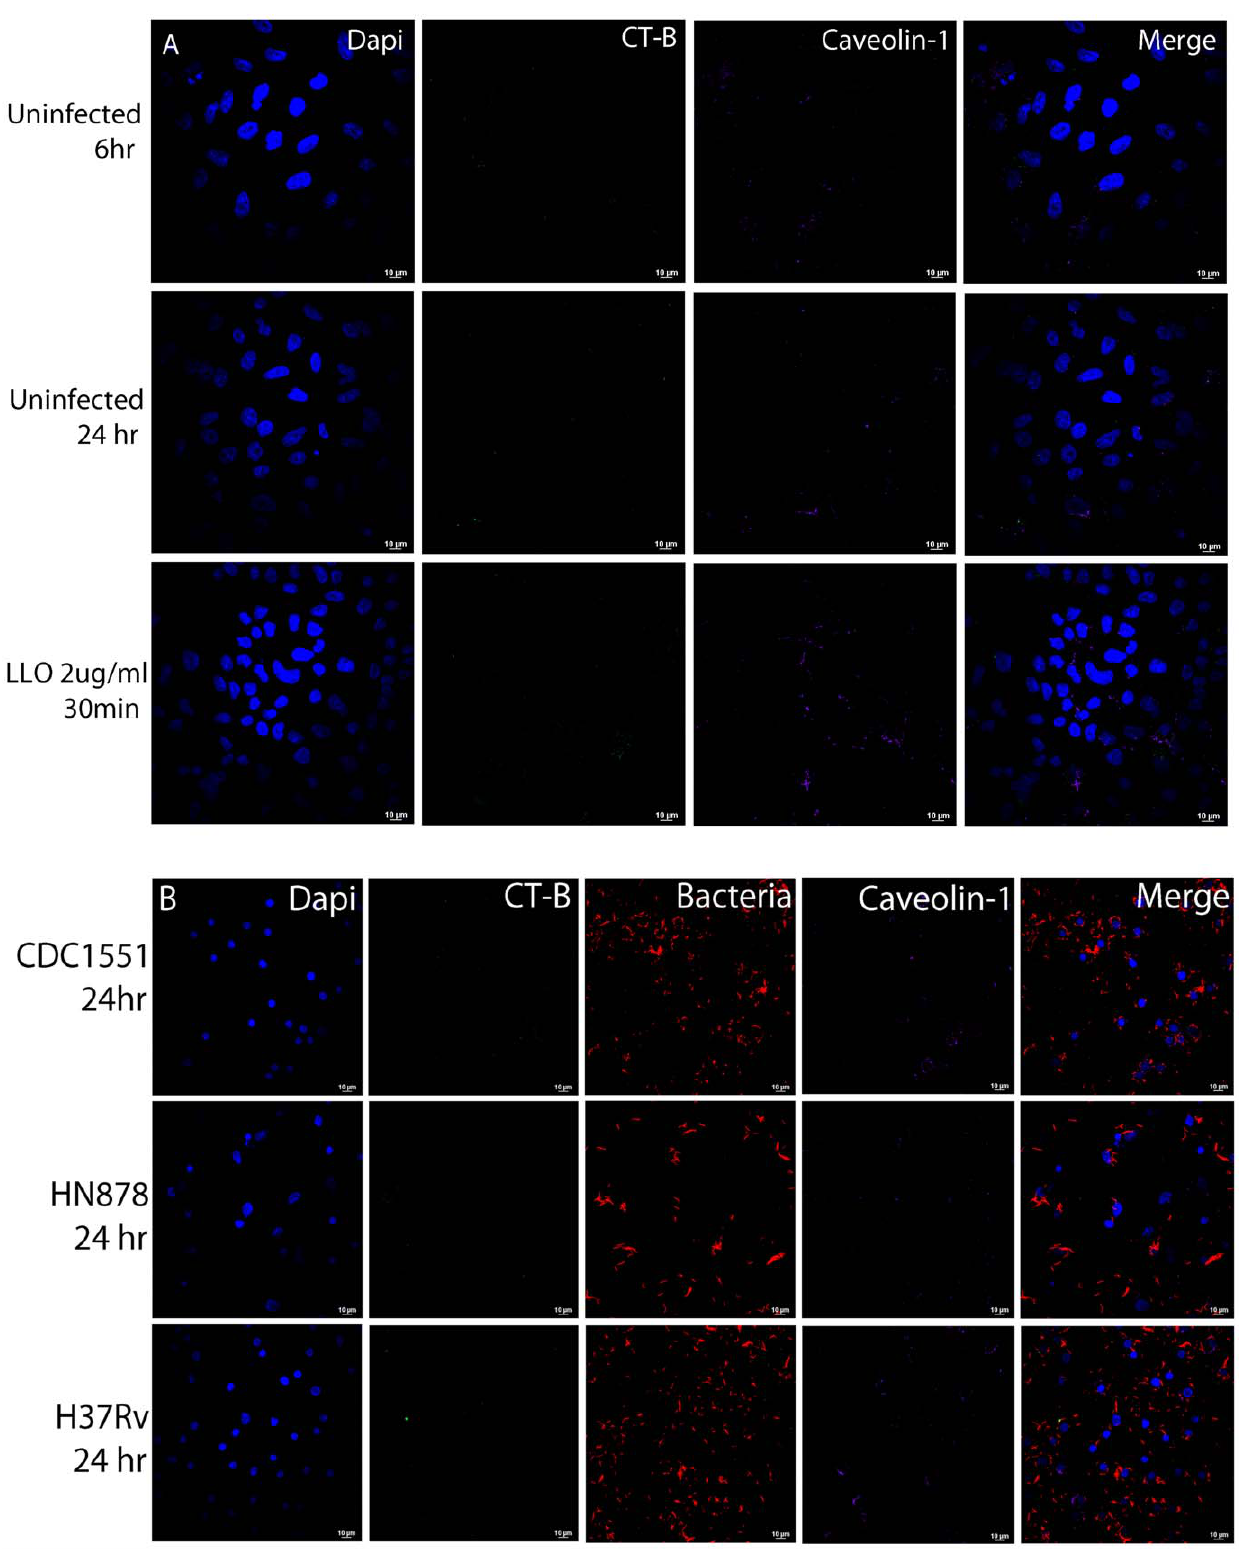
Figure 9. Treatment of epithelial cells with Filipin III disrupts mycobacterial-induced LR aggregation. A549 cells were treated with cholesterol-binding, LR-disruption agent Filipin III and LR aggregation observed for controls and infections with all three live Mtb strains. Confocal microscopy demonstrated an absence of CT-B puncta at 6 and 24 hpi for controls (A) and live Mtb strains (B). Images were collected at 63x magnification. Infections were performed in triplicate and repeated three times.